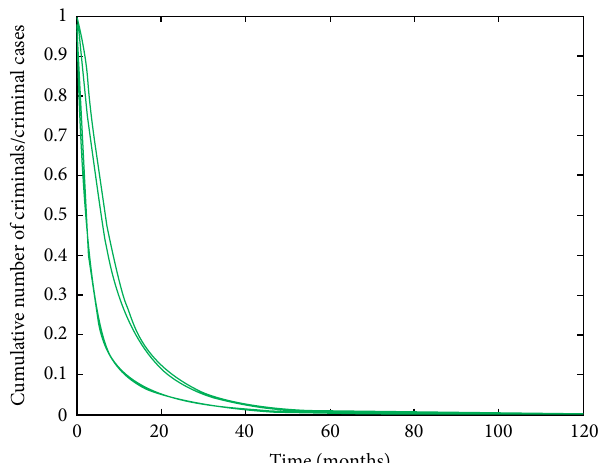
Figure 11: Simulation of model (4) using various initial conditions, showing cumulative number of crime/criminal cases when 𝛽 1 = 0.25 and . Other parameter values used are as given in Table 𝛽 2 = 1.25